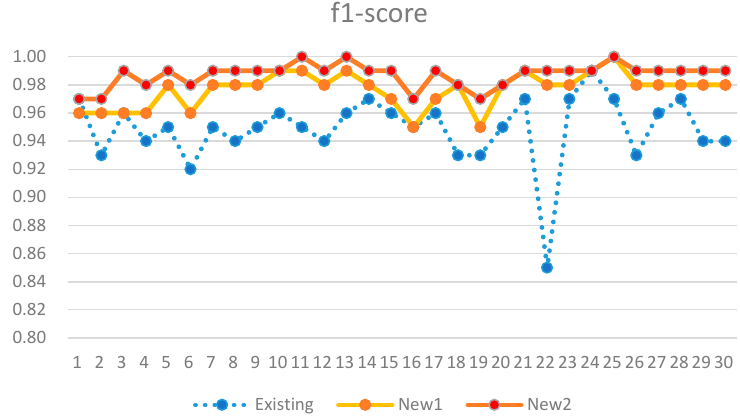
Figure 17. Performance comparison in f1-score metric.